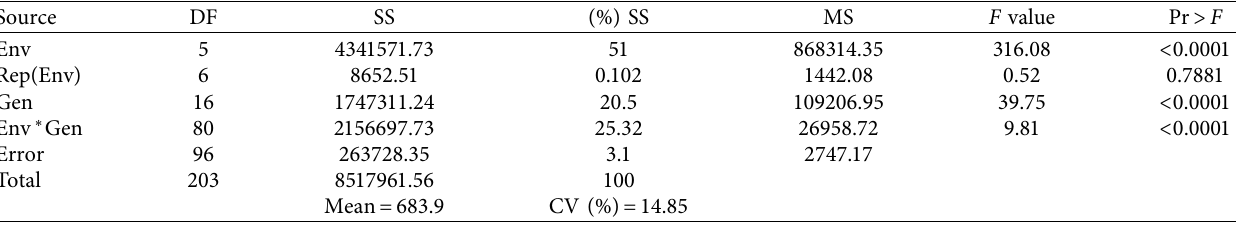
Table 3: Combined ANOVA for bean yield (kg ha − 1 ) and the percentage contribution of sum of squares of 17 genotypes tested at six environments. Source